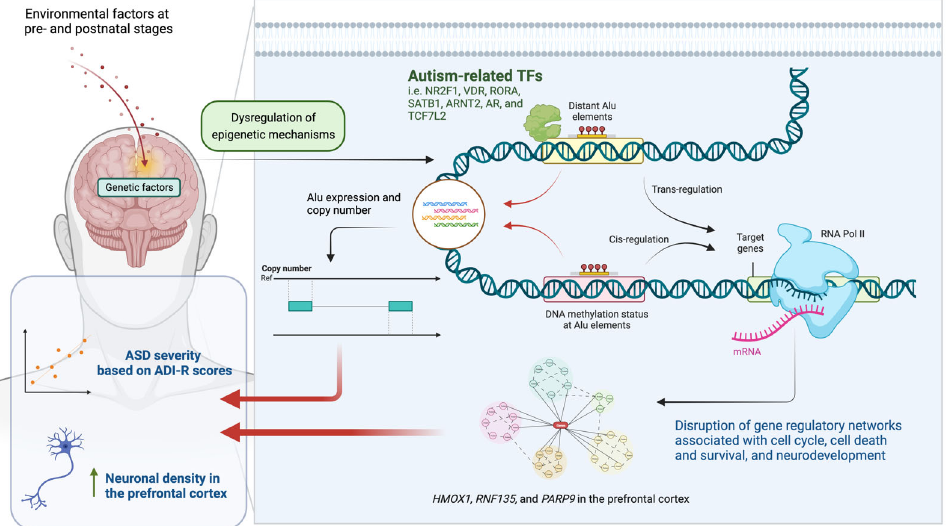
Figure 12. A schematic diagram illustrating a proposed mechanism by which Alu elements contrib ‐ ute to neuropathology in ASD brain tissues, as created with BioRender.com (accessed on 4 January